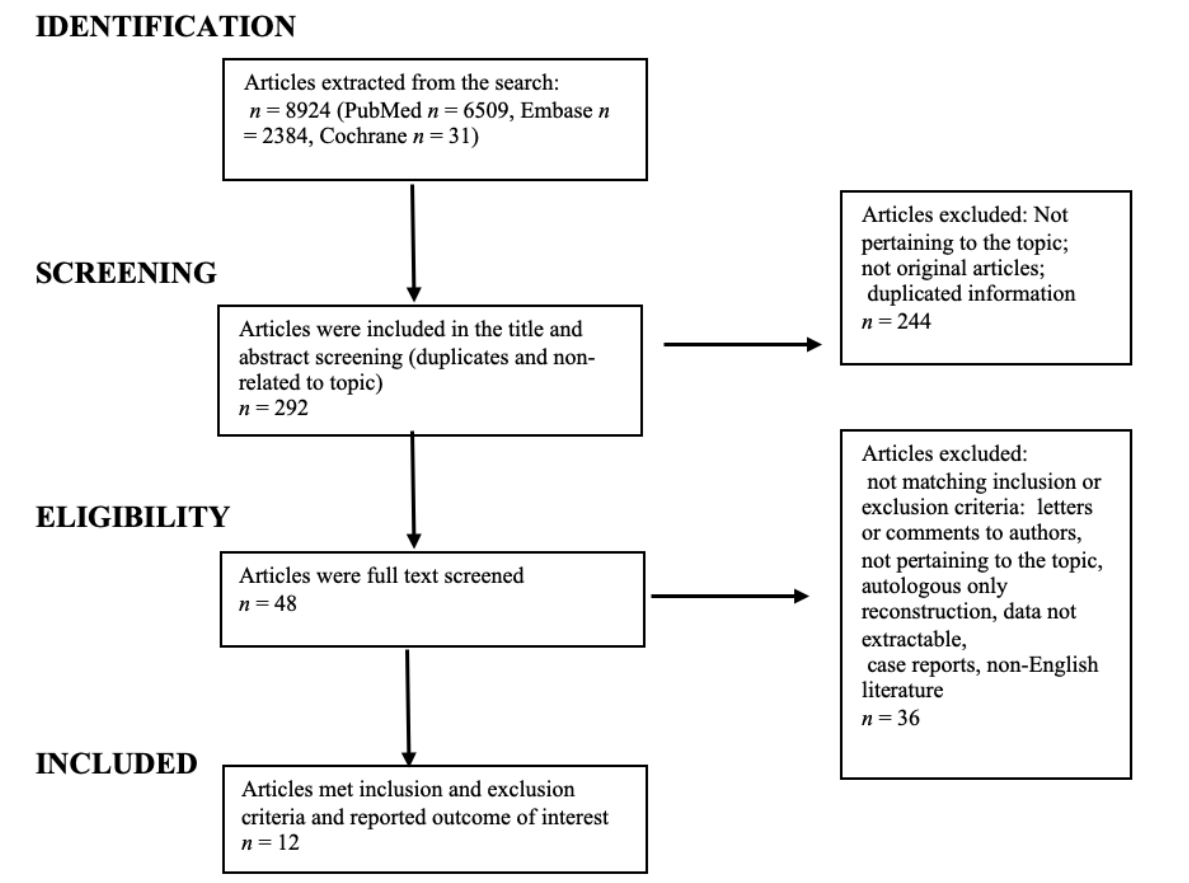
Figure 1. Flowchart of systematic review article selection process.